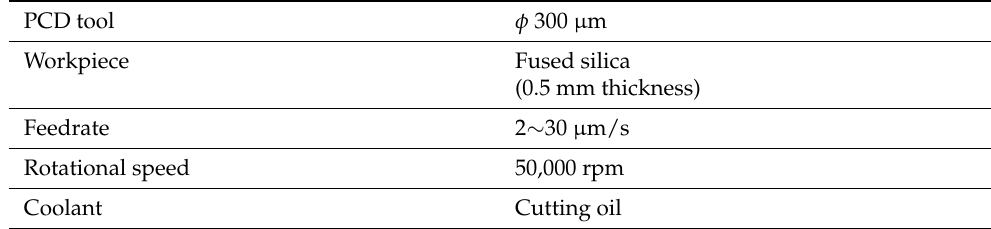
Table 2. Microdrilling conditions.